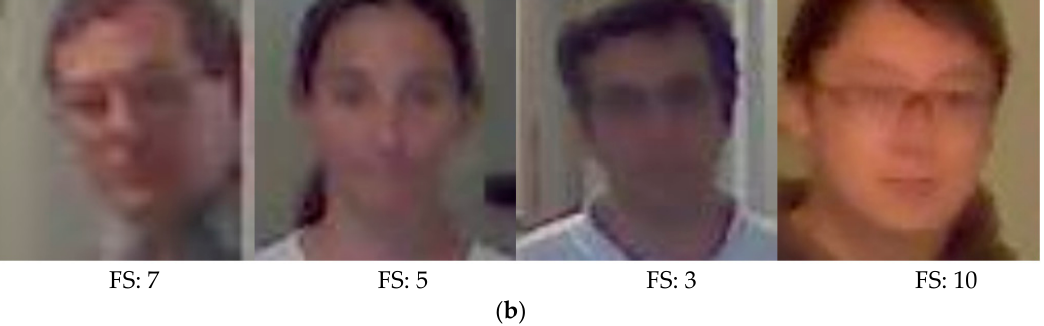
Figure 5. ChokePoint dataset focus score calculation example images: ( a ) Examples of images with a focus score (FS) above the threshold (20). ( b ) Examples of images with a focus score below the threshold.